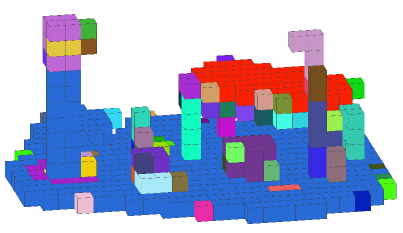
Figure 9: Clustering connected cells of the same dimensionality In the figure, random colors are designated to different clusters.